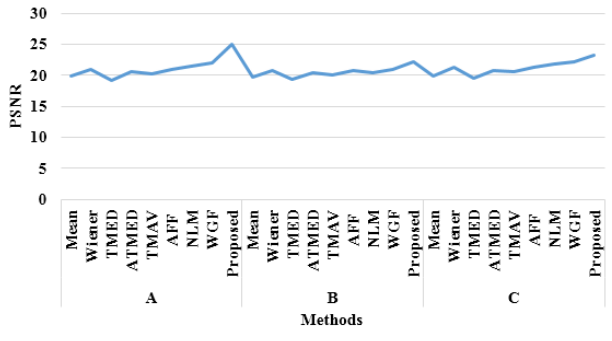
Figure 9: Graphical comparison of PSNR value (0.01 Level Gaussian